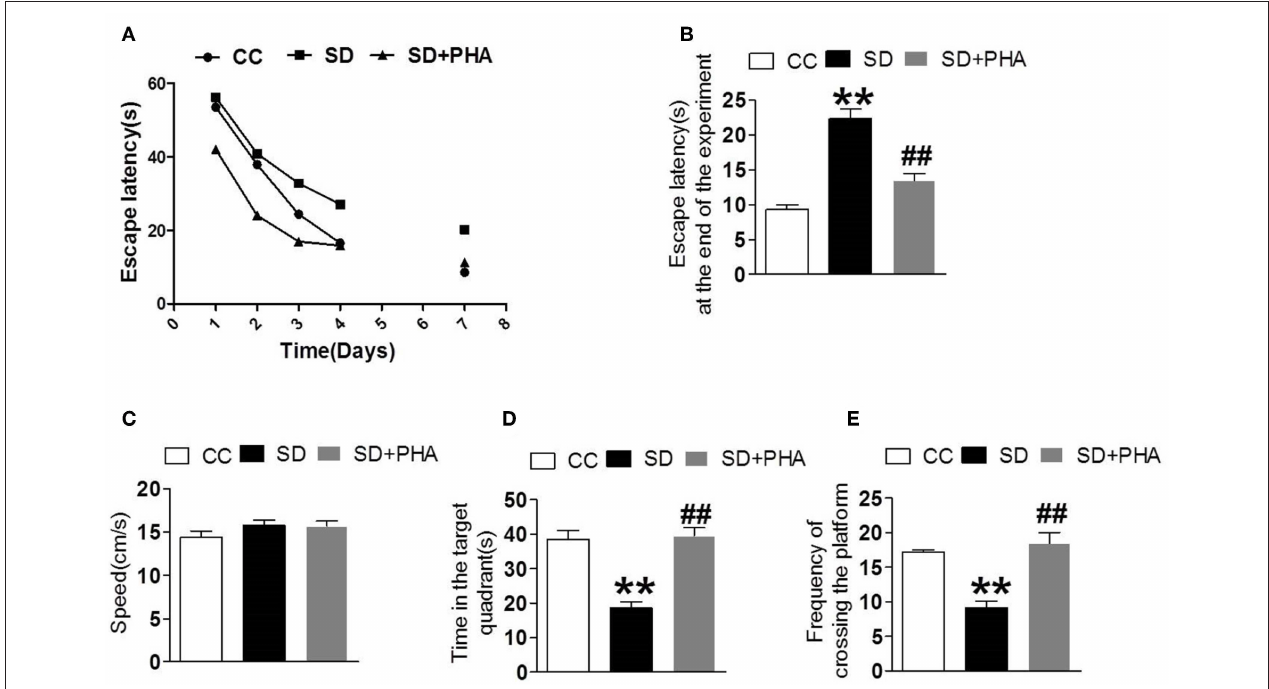
FIGURE 6 | Effects of cholinergic modulation on memory function following sleep deprivation. Water morris maze was used to test the learning and memory function of mice. (A,B) The escape latency of mice in the three groups decreased gradually and compared with CC group, the escape latency significant increased in SD group, the PHA-543613 treatment reduced the escape latency at the end of experiment. (C–E) Compared with the CC group, sleep deprivation decreased the frequency of crossing the platform, and shorten the time in the target quadrant. Following the PHA-543613 treatment, the frequency of crossing platforms and the time in the target quadrant was prolonged compared to the SD group. There was no significance in swimming speed among the groups. Data are expressed as means ± SEM. * P < 0.05, ** P < 0.01, vs. control group, # P < 0.05, ## P < 0.01, vs. SD + PHA-543613